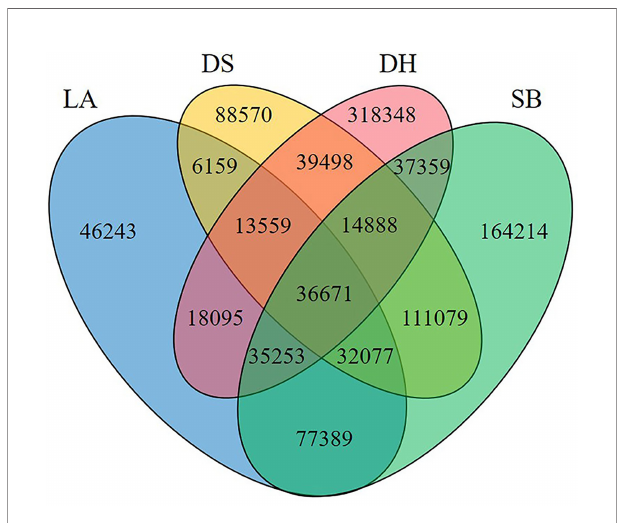
FIGURE 1 | Number of common and unique genes among different populations. LA (blue), Landrace piglets, SB (green), Saba piglets, DS (yellow), Diannan small-ear piglets, DH (red), Dahe